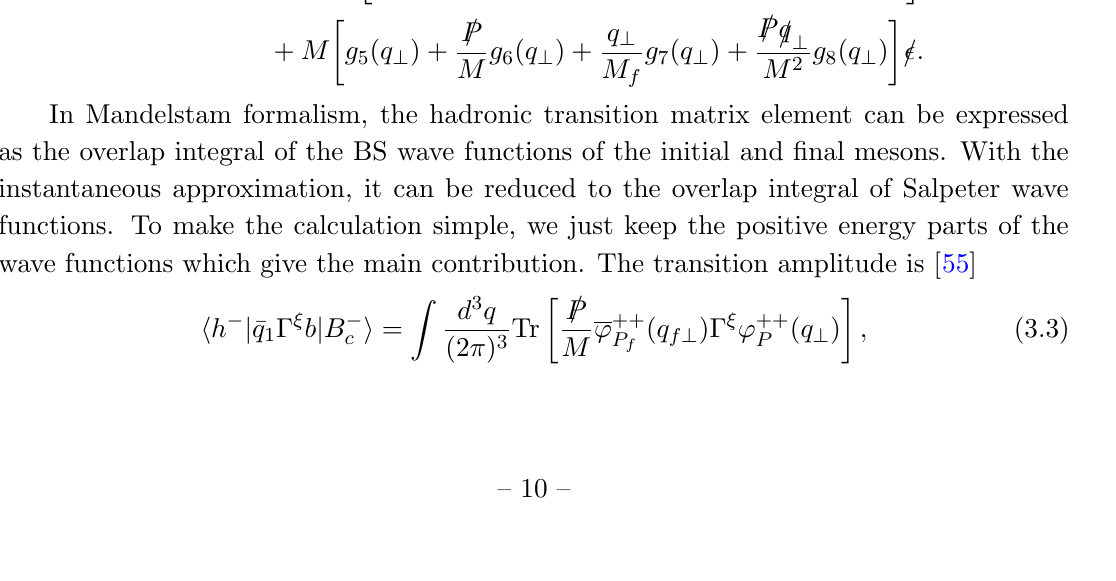
2 , 2 and g p 2 g p 3 j j j j